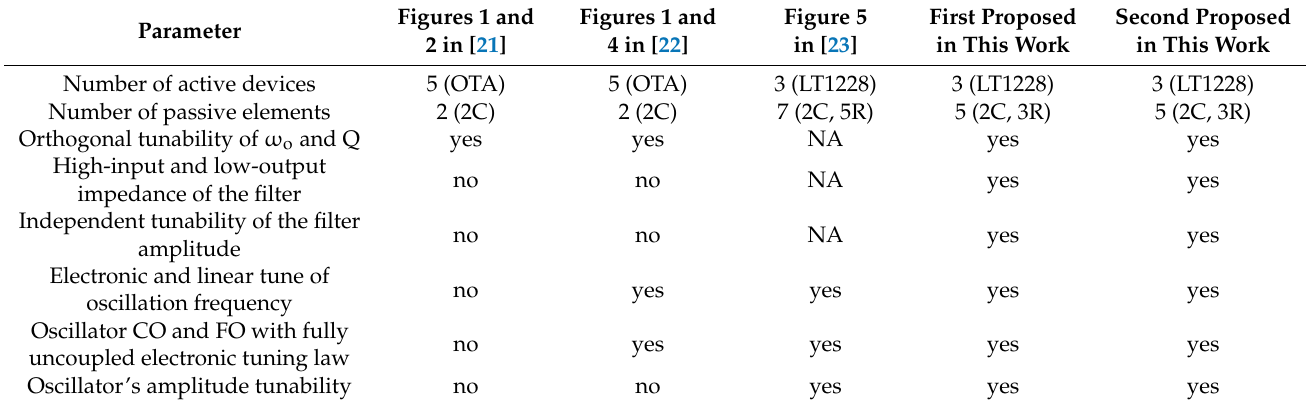
Table 1. Comparison between recent electronic tunable filter/oscillator circuits.